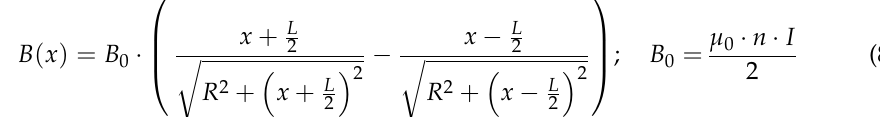
where the axis of the coil is parallel to (cid:126) B = [ B ( x ) , 0, 0 ] . For L (cid:29) R one obtains for B ( 0 ) ≈ µ 0 · n · I , and B ( ± L /2) ≈ 1/2 · B ( 0 ) (see Figure